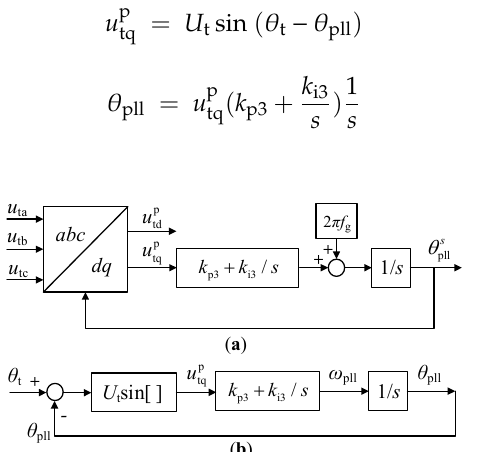
Figure 3. Diagram of PLL model [15]: ( a ) the actual structure of the PLL, ( b ) equivalent formulation in synchronous reference frame.